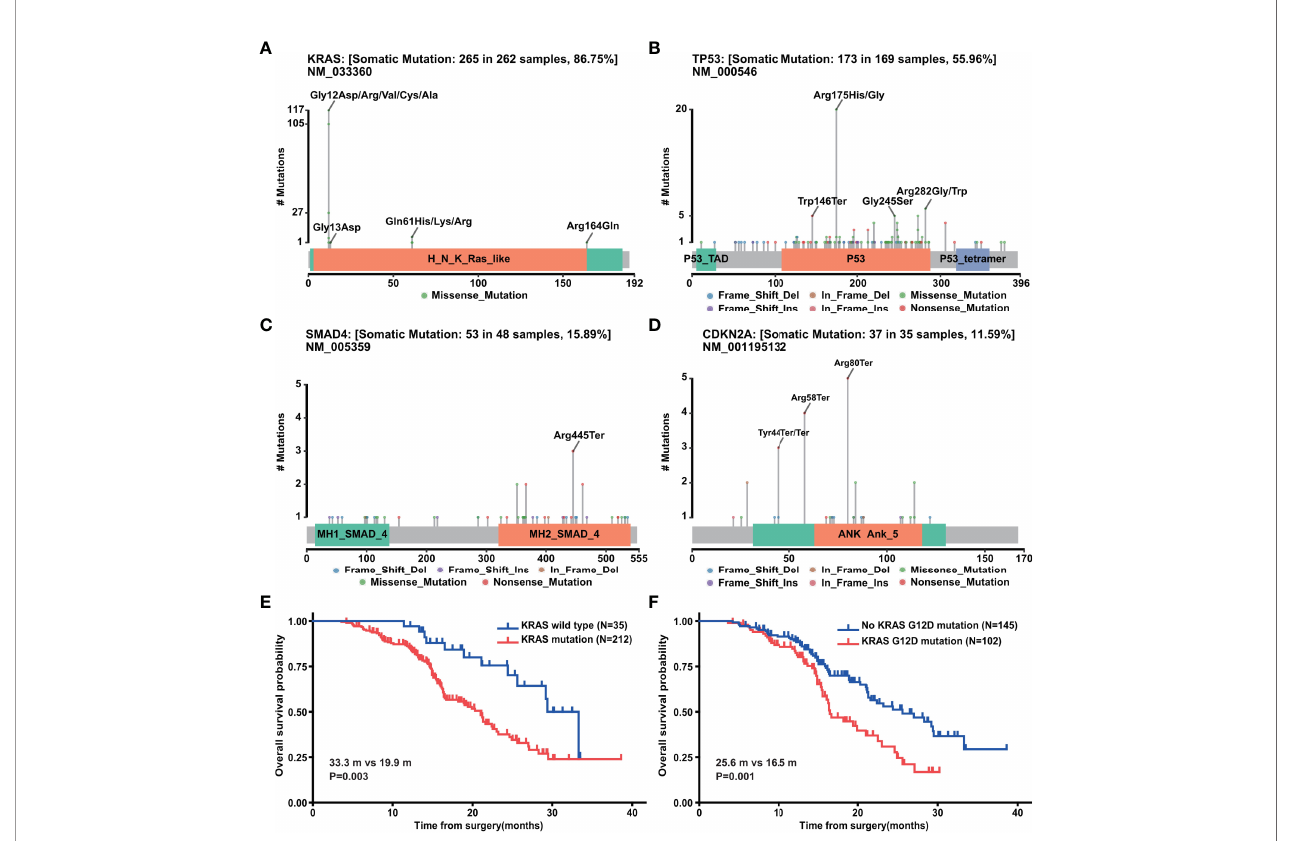
FIGURE 4 | Genetic mutation of PDAC. (A) Mutation sites of KRAS gene in PDAC (n=302). (B) Mutation sites of TP53 gene in PDAC (n = 302). (C) Mutation sites of SMAD4 gene in PDAC (n = 302). (D) Mutation sites of CDKN2A gene in PDAC (n = 302). (E) Overall survival analysis of above 247 PDAC patients with (n = 212) and without (n = 35) KRAS mutations. (F) Overall survival analysis of above 247 PDAC patients with (n = 102) and without (n = 145) KRAS G12D